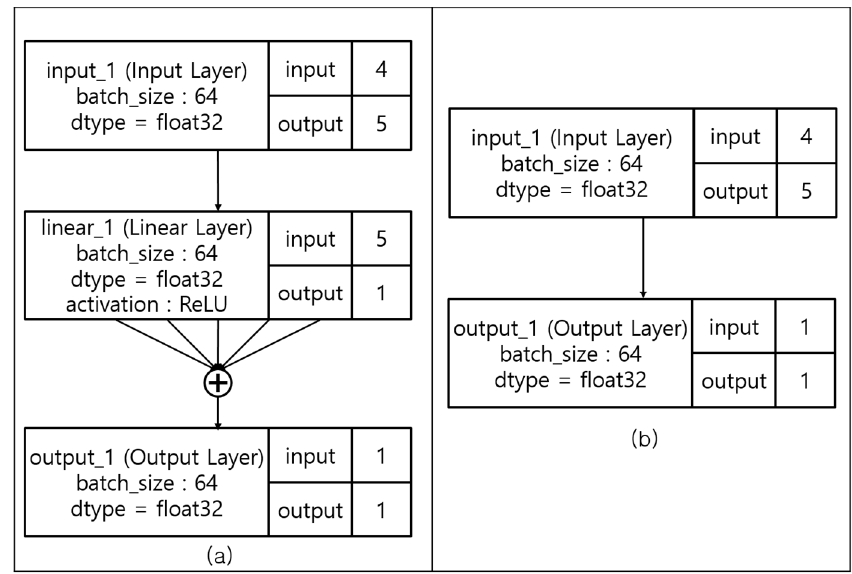
Figure 8. Comparison between Korean and English grammaticality task topology. ( a ) the generated architecture of the Korean grammaticality task; ( b ) the generated architecture of the English grammaticality task.